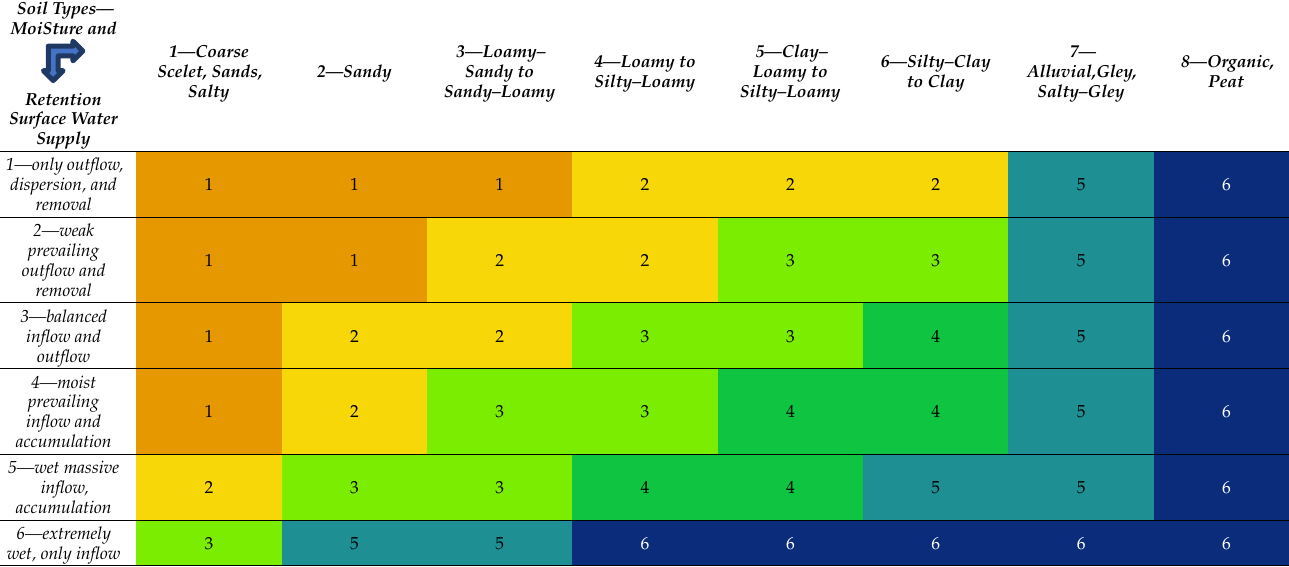
Table 2. Relative values of the moisture regime and morpho-pedotop topographic humidity. (Moisture regime of the soils: 1—very dry and coarse morpho-pedotops, 2—dry, sandy morpho-pedotops, 3—balanced morpho-pedotops, 4—moist